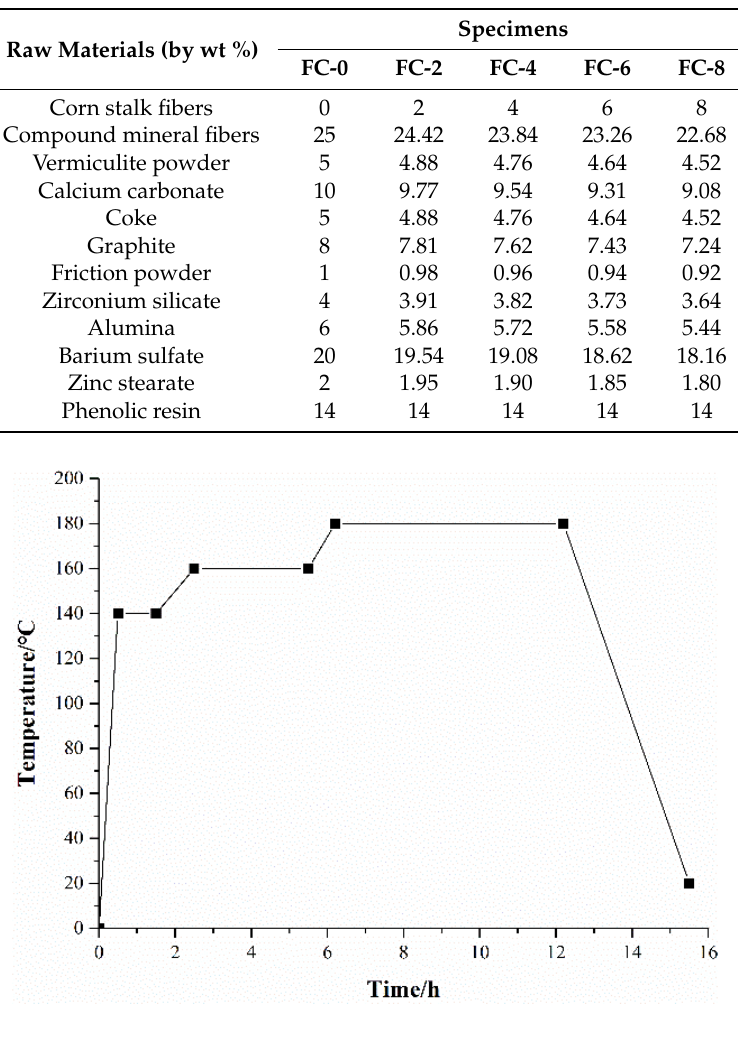
Figure 1. Heat-treatment process of the composites.